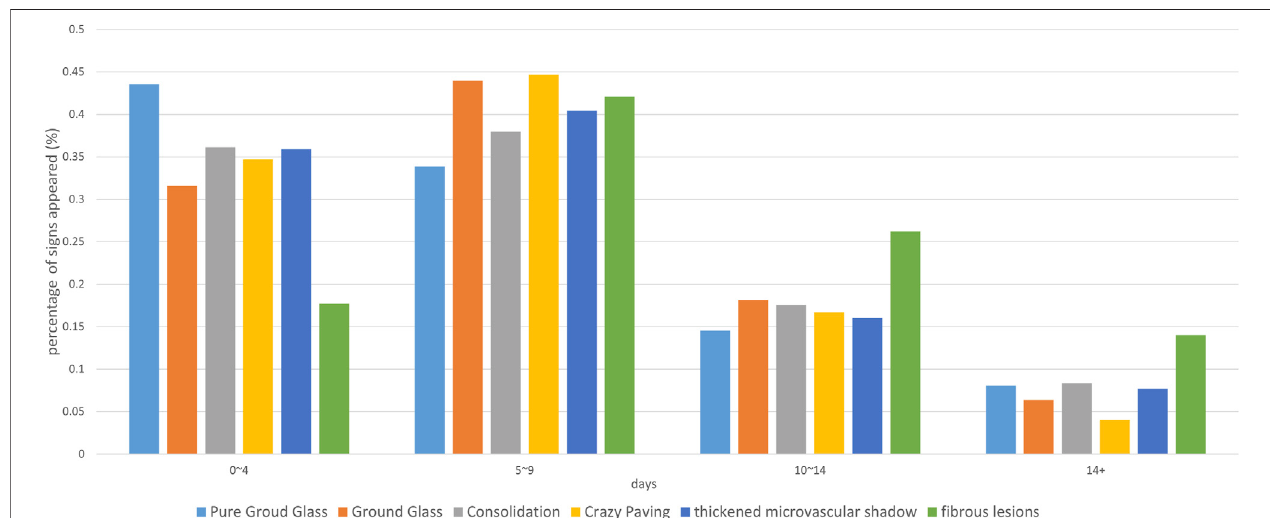
FIGURE 2 | The percentage of time at each CT sign. The horizontal axis is the date of onset, and the vertical axis represents the percentage of the number of positive cases with the corresponding sign to all cases with the sign on that date.